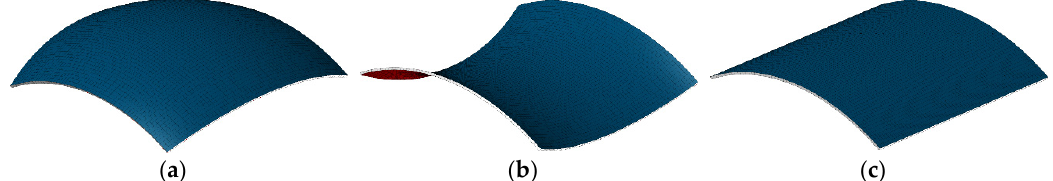
Figure 3. Geometries of shell structures considered in the applications: ( a ) Spherical shell; ( b ) hyperbolic paraboloidal shell; ( c ) circular cylindrical shell.